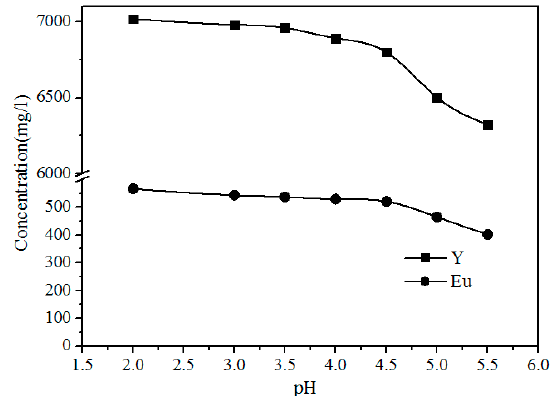
Figure 10. Effect of pH on the concentration of Y and Eu in the leach solution.